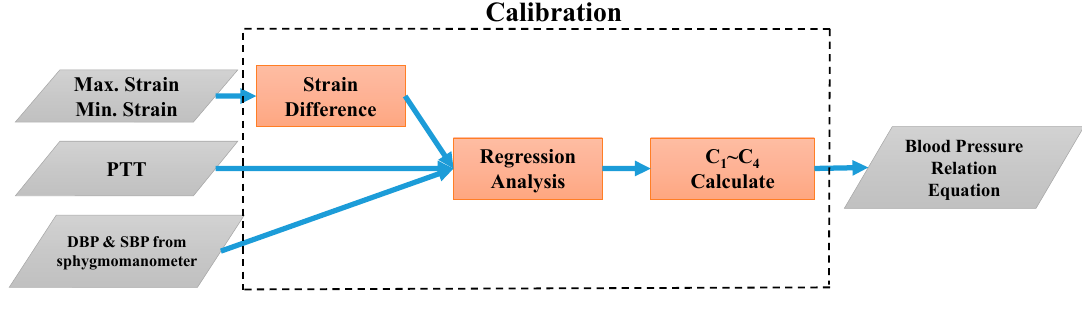
Figure 8. Schematic of the front-end circuit designed for the photoplethysmography (PPG) sensor.